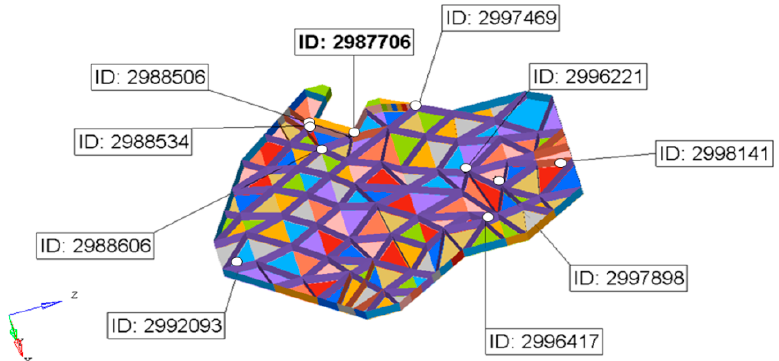
Figure 5. NIRSpec module’s optical bench with the ten most stressed elements highlighted, with a perspective from below in order to depict all ribs stiffening the bench.